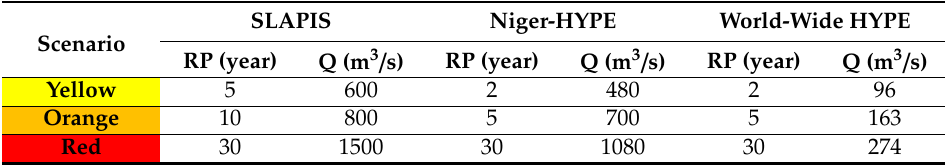
Table 2. Hazard thresholds for the Sirba River at Garbey Kourou hydrometer in SLAPIS and for Niger HYPE and World-Wide HYPE. “RP” is the return period magnitudes in